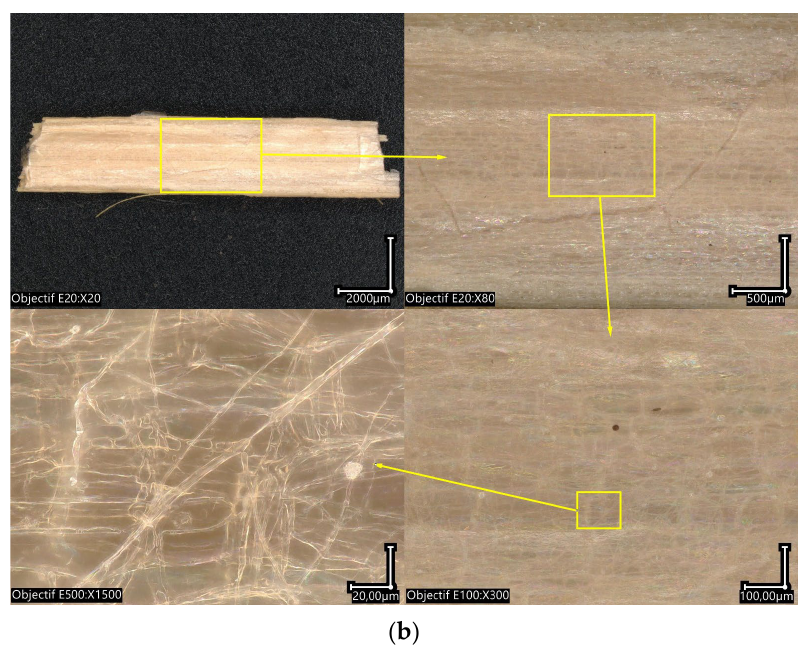
Figure 4. Cross section ( a ) and longitudinal ( b ) microsopic observations of a straw fiber.